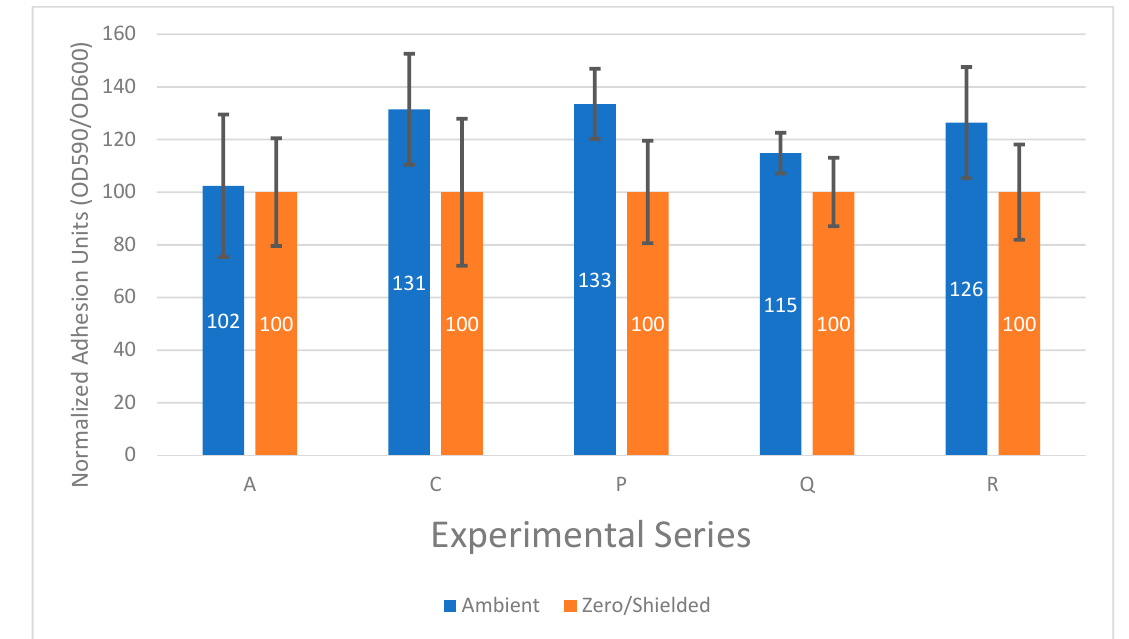
Figure 3. Effect of ambient versus shielded conditions on Biofilm Adhesion Units (ratios of OD590/OD600) and normalized to control condition “Zero/Shielded (value at 100)”. Data points and standard deviations shown for five experimental series (A–R) under two conditions: “Ambient/room”, “Zero/shielded”. Y-axis show normalized biofilm ratios relative to the “Zero/shielded” condition (value 100).